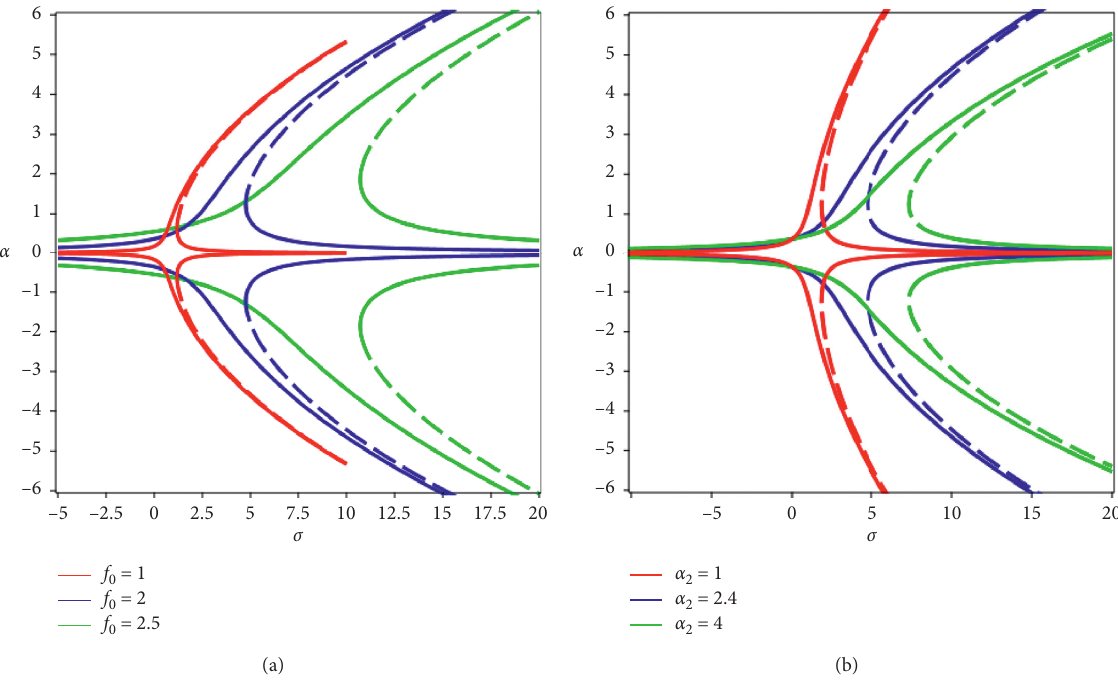
Figure 5: Frequency response for the third-order superharmonic resonance. (a) Ω ≈ 1/3, α � 0 . 0034, and f � 2. Solid and broken lines are used for the loci of stable and unstable responses, α 1 0 the curves have a similar structure as one changes the damping α . As the value of α is increased, the resonance curve envelope 1 1 gradually shrinks. In Figure 4(b), the effect of excitation load f